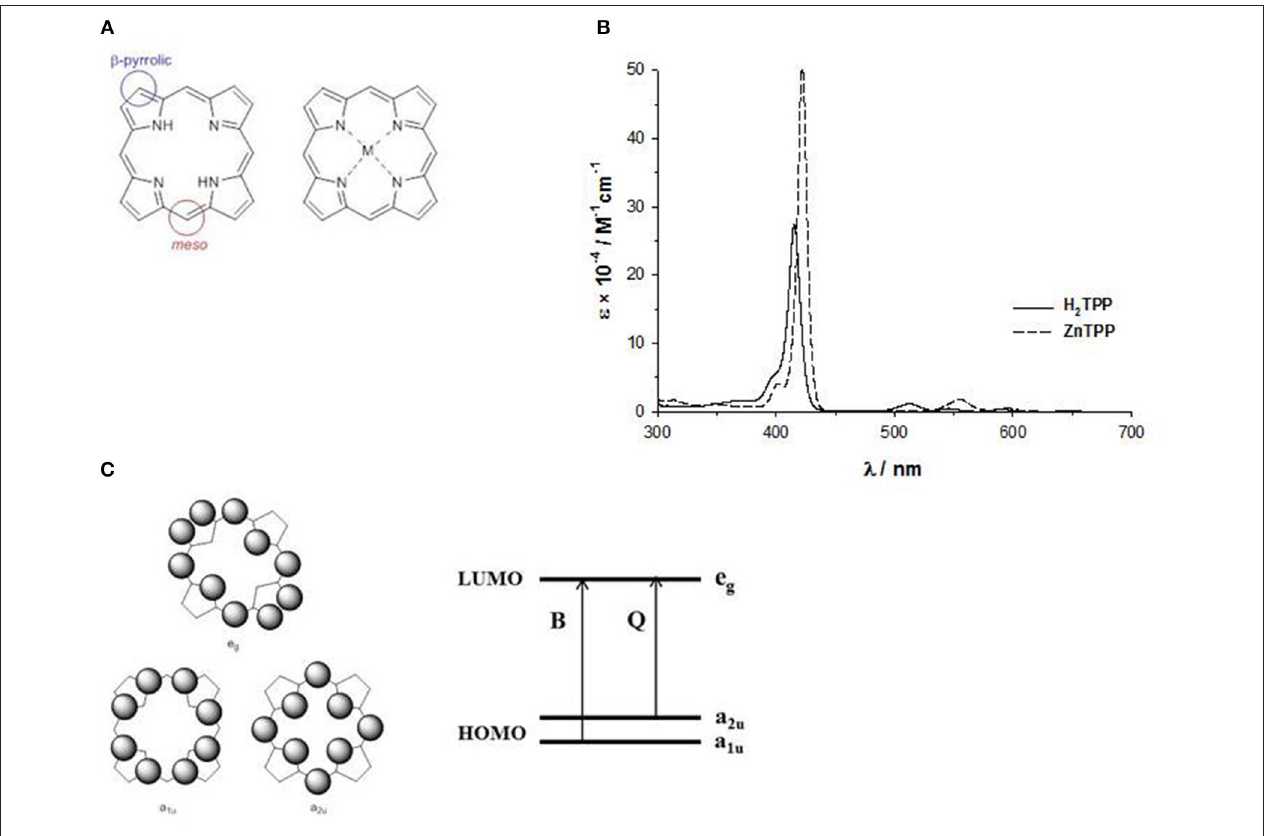
FIGURE 2 | (A) meso and β -pyrrolic positions in porphine; (B) UV-Vis spectrum of H 2 -tetraphenylporphyrin and Zn II -tetraphenylporphyrin in THF solution; (C) HOMO and LUMO orbitals according to the four orbital model of